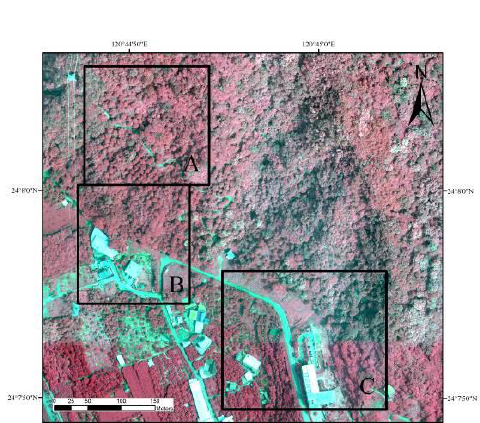
Figure 1. Site for training data